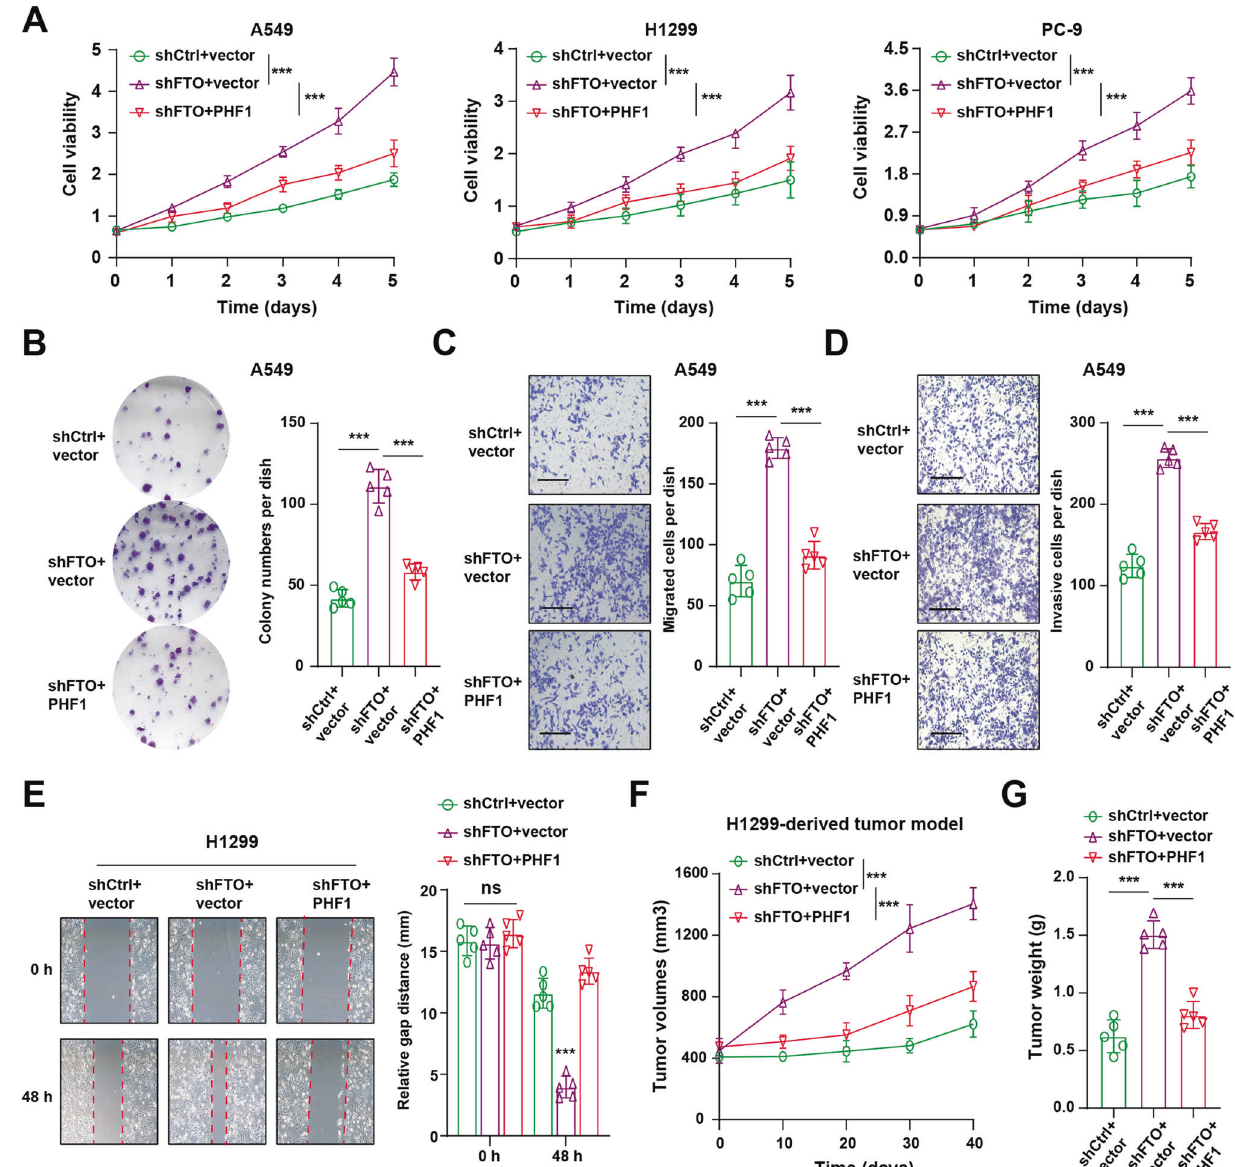
Fig. 5 PHF1 overexpression restored the elevated tumor progression induced by FTO inhibition. A CCK-8 assays showing the in vitro cell growth capacity of FTO-KD cells transfected with vector or PHF1 in three LUAD cell lines (A549, H1299 and PC-9) ( N = 5 per group). B Colony formation assay was conducted in FTO-KD A549 cells transfected with vector or PHF1. C Migration assay was conducted in FTO-KD A549 cells transfected with vector or PHF1. D Invasive assay was carried out in FTO-KD A549 cells transfected with vector or PHF1. E Wound-Healing assay was conducted in FTO-KD A549 cells transfected with vector or PHF1. F Quanti fi cation of tumor volumes in the H1299-derived tumor model incoporating three groups: shCtrl + vector, shFTO + vector and shFTO + PHF1. G Quanti fi cation of tumor weight in the H1299-derived tumor model incoporating the above three groups. Bar = Mean ± SD. * P < 0.05, ** P < 0.01, *** P <